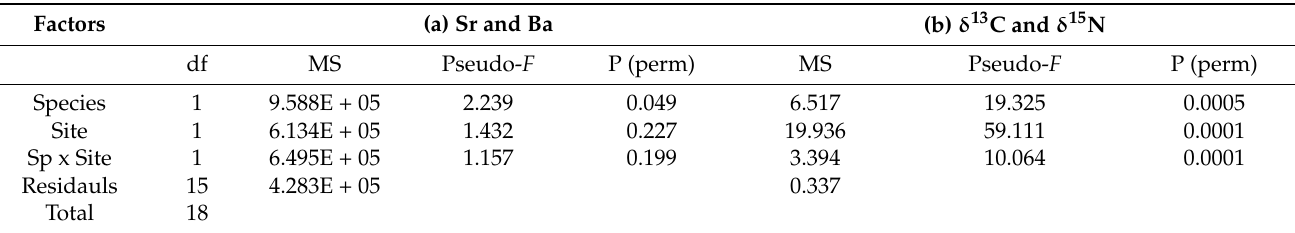
Table 3. Summary of PERMANOVA results for the multivariate analysis of overall elemental composition of strontium (Sr) and barium (Ba) in otoliths ( a ) and overall carbon ( δ 13 C) and nitrogen ( δ 15 N) stable isotope values in muscle tissue ( b ) for juvenile Diplodus puntazzo and Diplodus vulgaris collected at different sites.